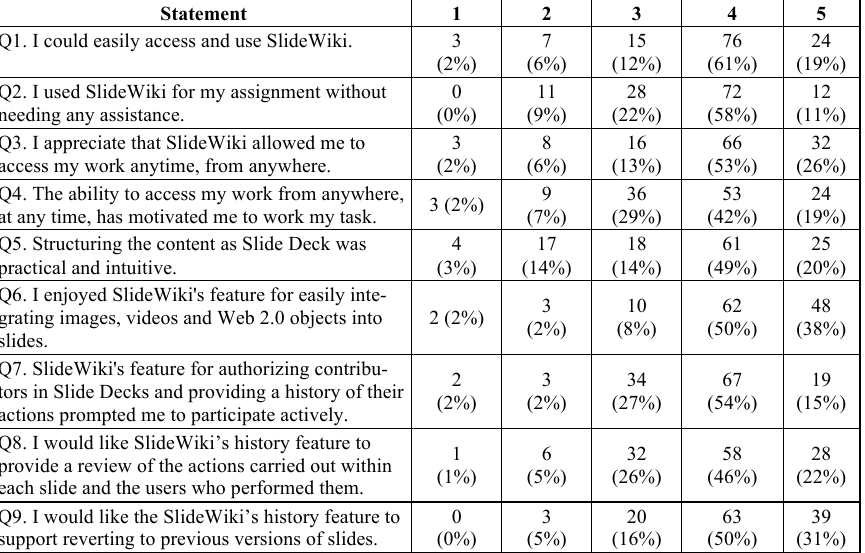
Table 1. Distribution of students’ responses in statements Q1 to Q9 of Section A Statement 1 2 3